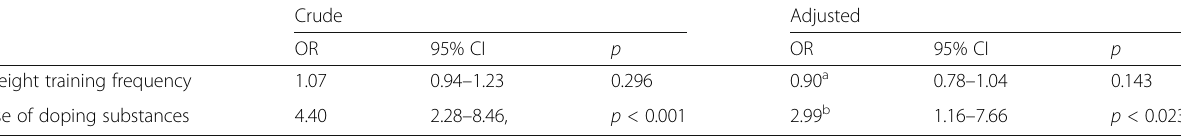
Table 4 Associations between illicit drug use and weight training frequency and use of doping substances, respectively ( n =